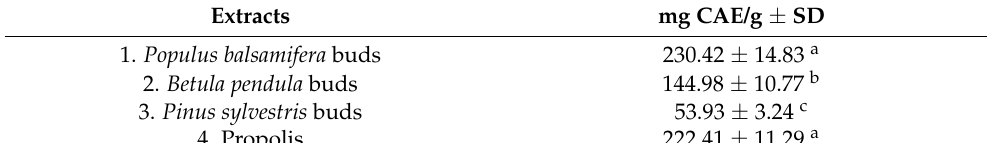
Table 1. Poplar buds, birch buds, pine buds and propolis total amount of phenolic compounds expressed as mg CAE/g dry weight (DW). Results are presented as mean and standard deviation of three measurements. Different subscript letters indicate a statistically significant difference between samples ( p < 0.05).